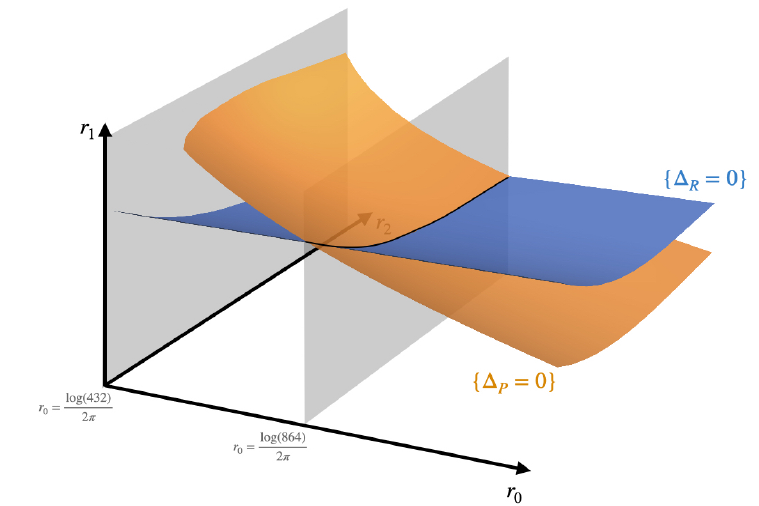
Figure 1 . This figure shows the boundary of the amoeba associated to the singular locus { ∆ = 0 } for the smooth Weierstrass model over B = F projected to the real part, r 2 1 parameters. Shown is only the quadrant describing the CY phase of the GLSM. The orange plane shows the amoeba for the principal singularity { ∆ = 0 } whereas the blue plane corresponds to the P amoeba of { ∆ = 0 } . The Kähler cone corresponds to the space bounded by the { ∆ R the plane spanned by the ( r ) axes, and the grey plane corresponding to constant r 0 , r 1 We further indicated the plane r = log864 where the boundaries of the amoebas of ∆ 0 2 π